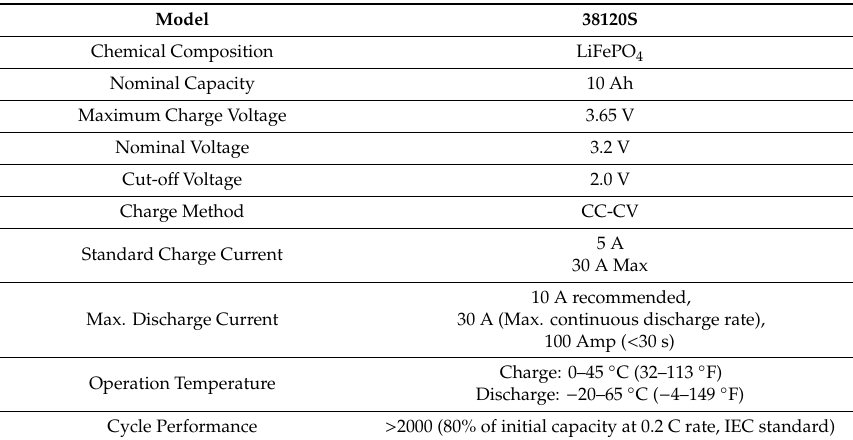
Table 1. Specification of a Headway 38120S 10 Ah LiFePO 4 battery.